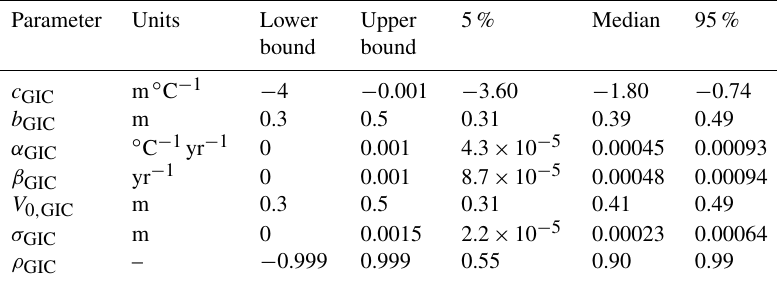
Table A6. Prior probability distribution ranges for the GIC- SIMPLE model parameters, and median, 5th, and 95th quantiles of the calibrated posterior parameter distributions. The priors are all uniformly